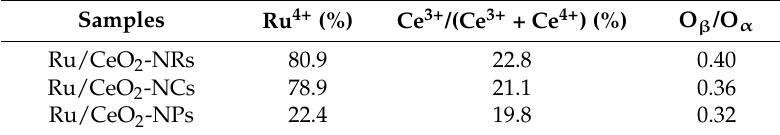
Figure 7. O 1s XPS spectra of ( a ) Ru/CeO 2 -NRs, ( b ) Ru/CeO 2 -NCs, and ( c ) Ru/CeO 2 -NPs. Table 3. XPS data of Ru/CeO 2 -NR, Ru/CeO 2 -NC, and Ru/CeO 2 -NP samples. Samples